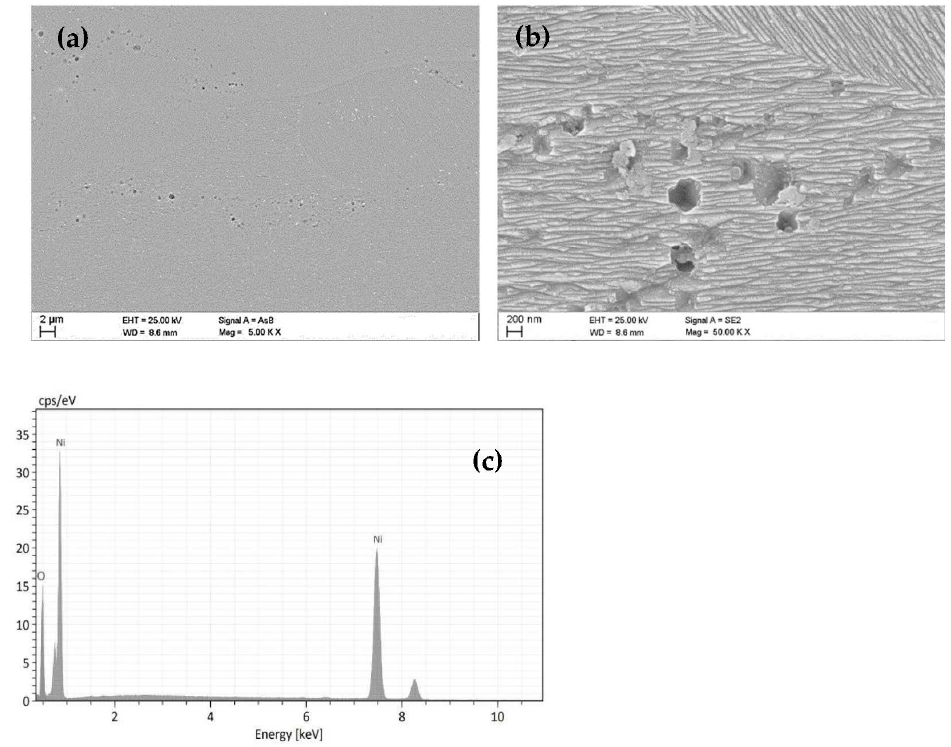
Figure 14. SEM pictures of MM deformed at 1300 °C – 0.001 s − 1 at ( a ) low magnification and ( b ) high magnification, and the ( c ) EDXS analysis on the area shown in figure ( b ).